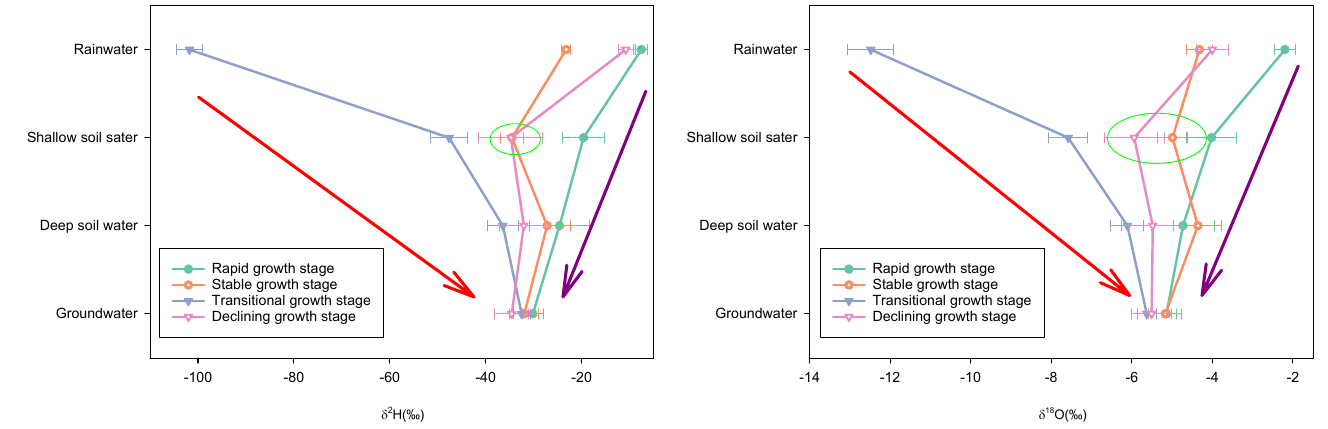
Figure 8. The symbols in the figure represent arithmetic means. During different stages, from rainwater to shallow soil water, then to deep soil water, and then to groundwater, δ 2 H and δ 18 O monotonically increasing or decreasing, except the points inside ovals, which is the evidence of the isotopes fractionation existing when water moves from bottom to top in soil. (See the Table 3 for detailed data). The arrows represent the direction of isotope composition change, which were generally unidirectional for the same